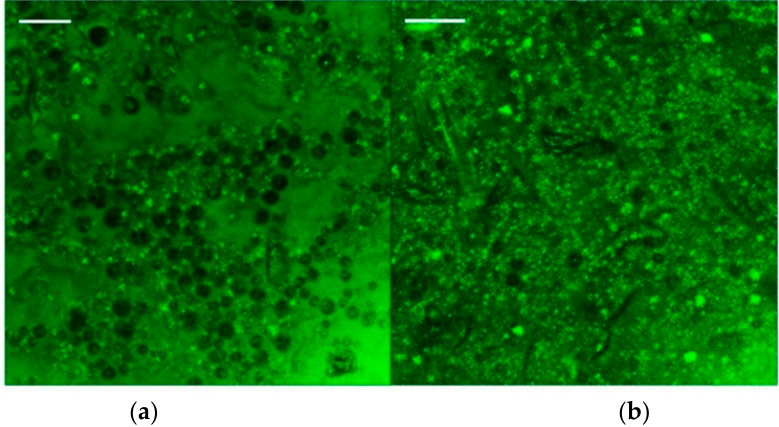
Figure 8. Confocal micrographs for samples E2.3.1.20 ( a ), E2.3.3.20 ( b ); magnification 25×; reference bar corresponds to 50 µm.